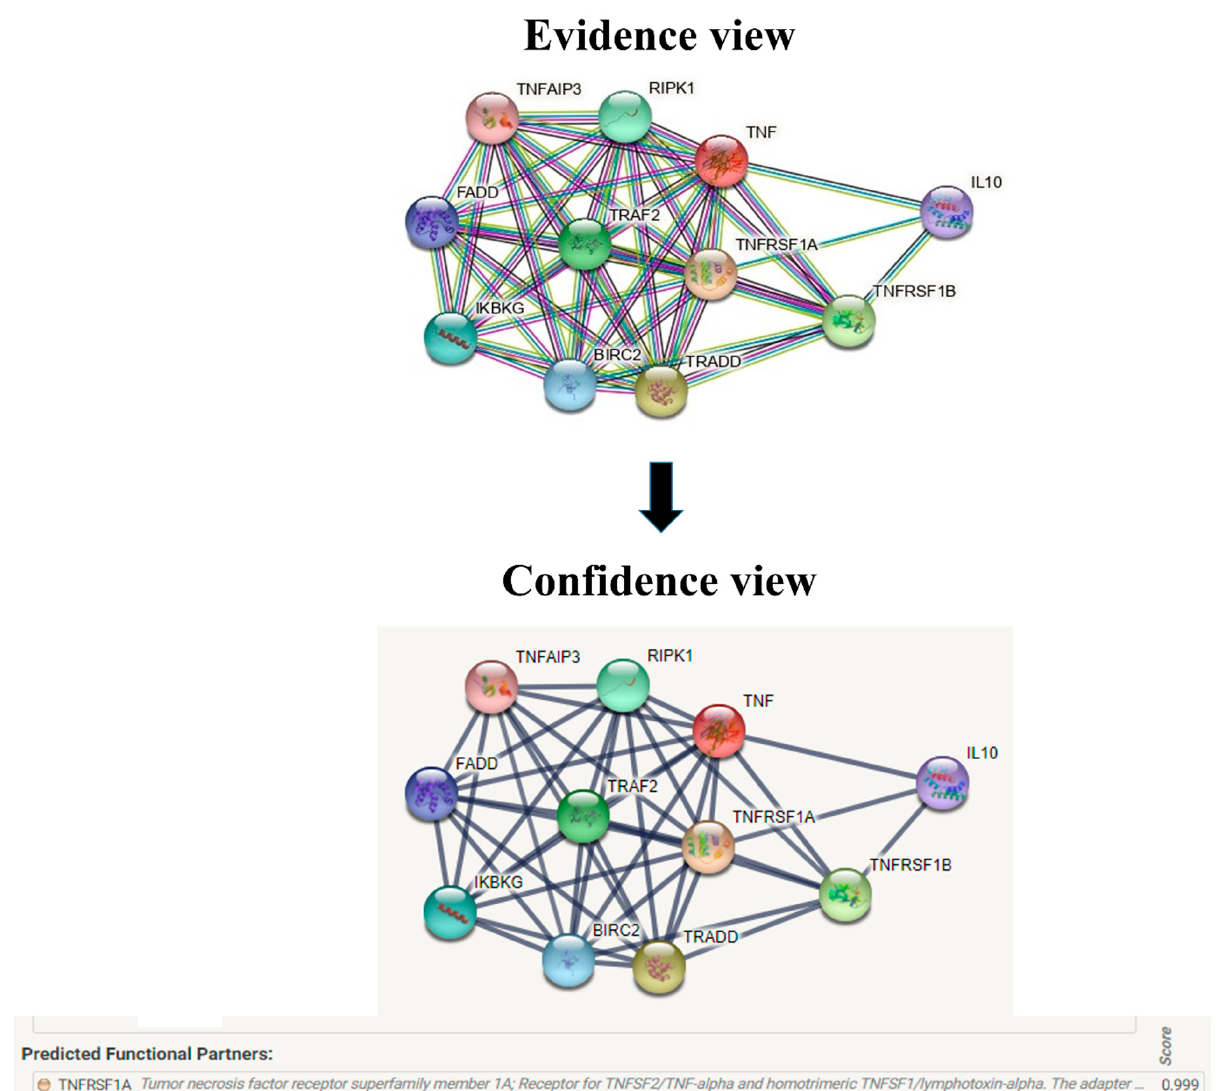
Figure 10. Overview of TNF- α network construction using String server 11.5. The evidence view and confidence view are given.